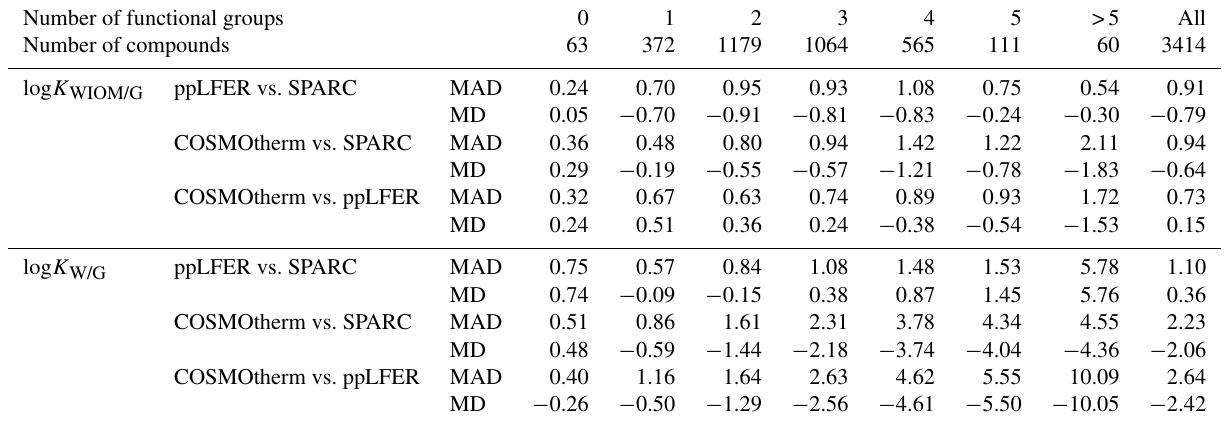
Table 1. Mean absolute differences (MADs) and mean differences (MDs) between SPARC, ABSOLV–ppLFER, and COSMOtherm predic- tions for compounds with different numbers of functional groups. Number of functional groups 0 1 >5 All Number of compounds 63 log K WIOM/G ppLFER vs. SPARC MAD COSMOtherm vs. SPARC MAD COSMOtherm vs. ppLFER log K W/G ppLFER vs. SPARC COSMOtherm vs. SPARC MAD MD COSMOtherm vs. ppLFER